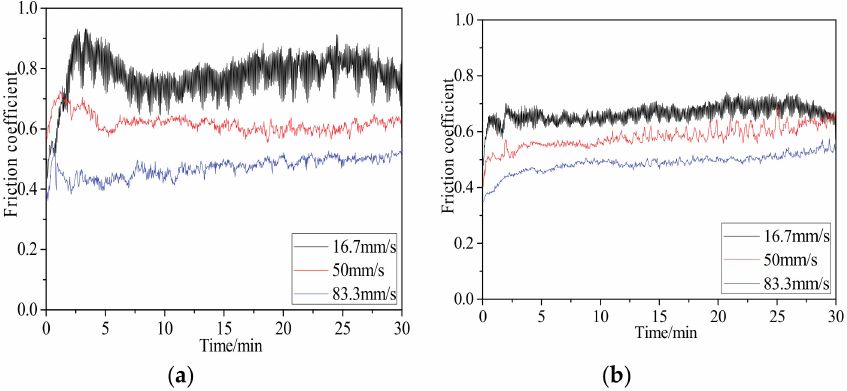
Figure 10. The friction coe ffi cient curves of untreated specimens and plasma-nitrided specimens under di ff erent sliding speeds: ( a ) untreated, ( b )